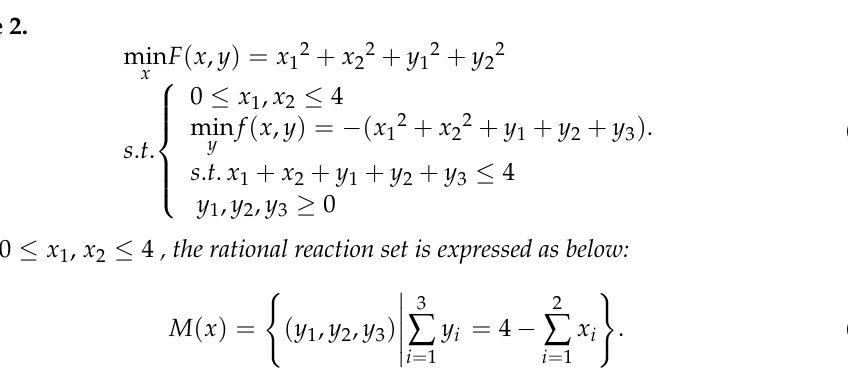
(cid:0) F nap , f nap